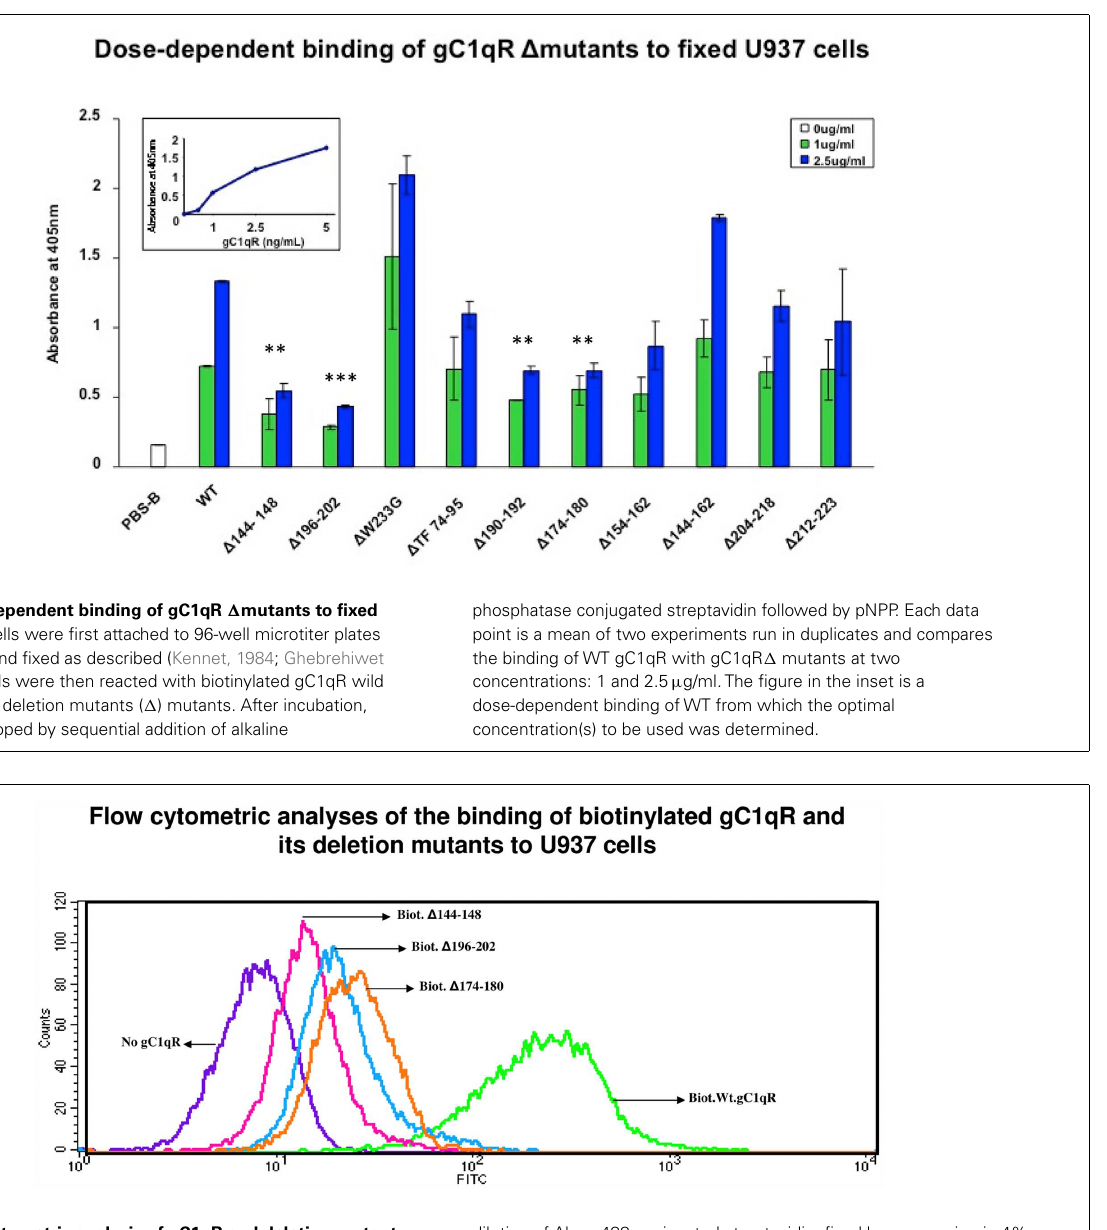
dilution of Alexa-488 conjugated streptavidin, fixed by suspension in 4% paraformaldehyde and then subjected to analysis by flow cytometry.The figure is a representative of two such